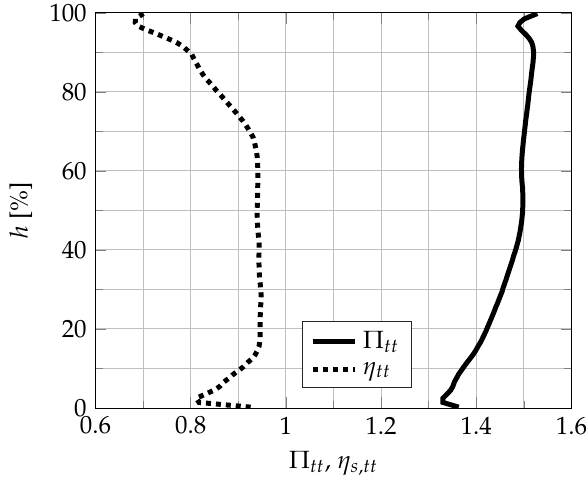
Figure 8. Fan pressure ratio and efficiency over the channel height for the design point.